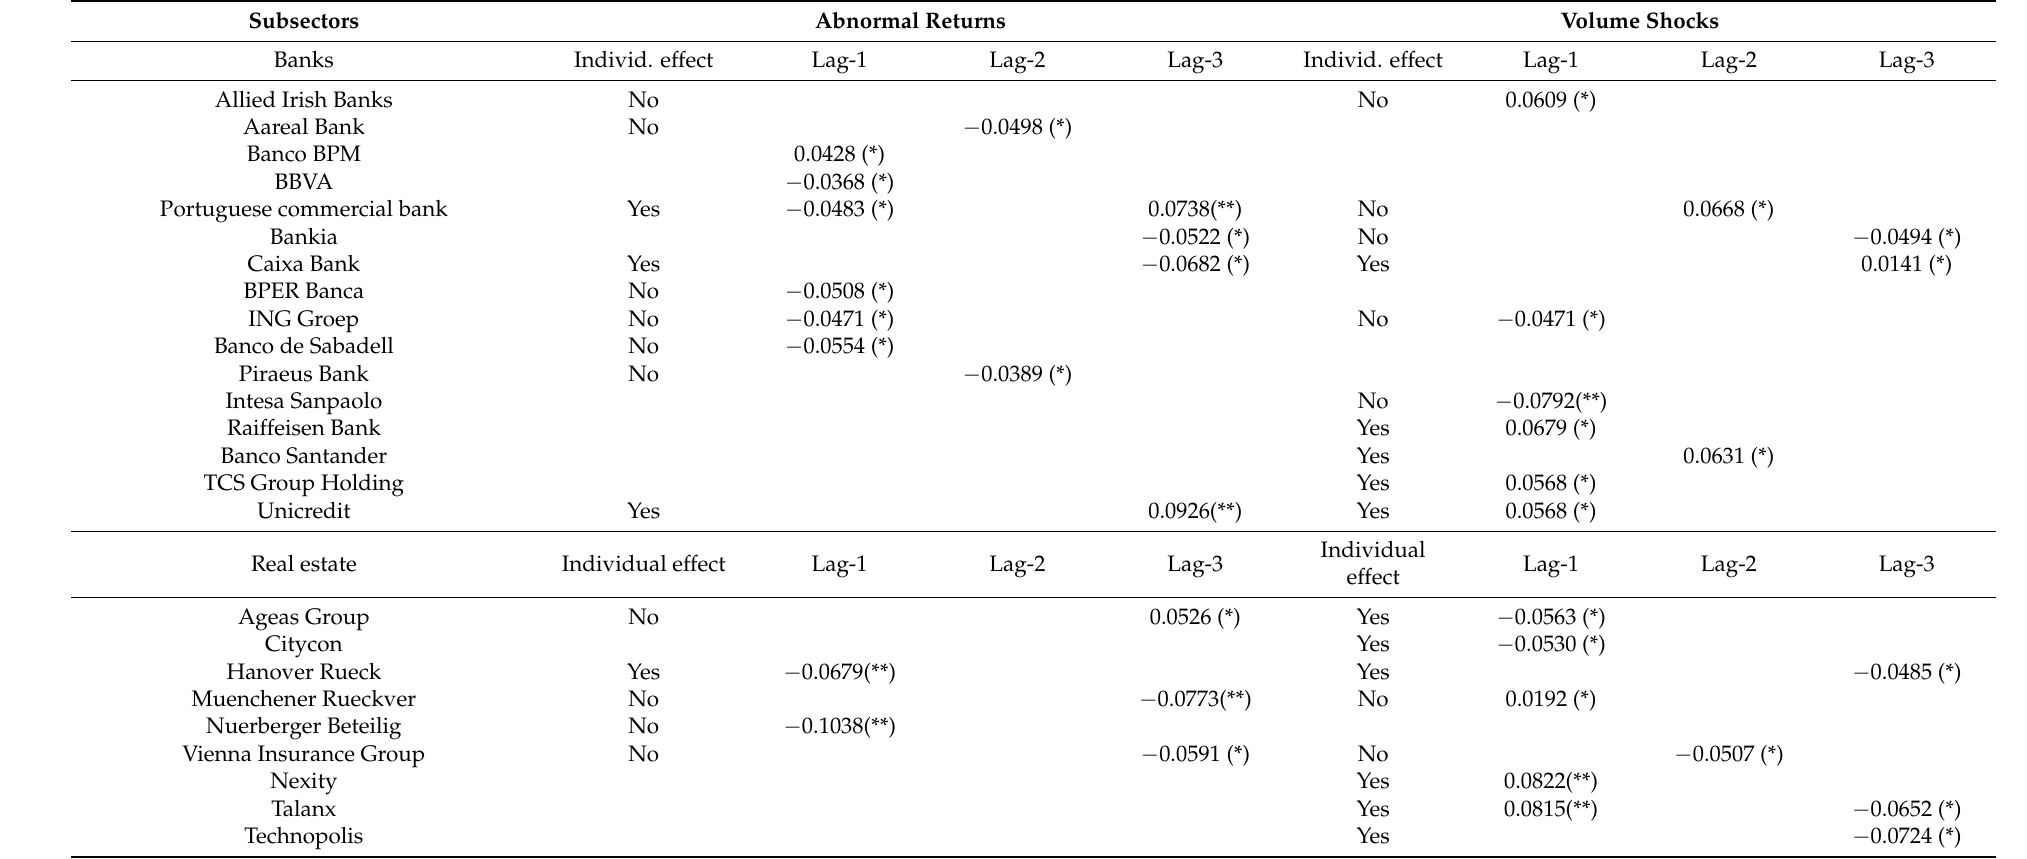
Table 7. Subsectors estimate of the influence of the investor sentiment